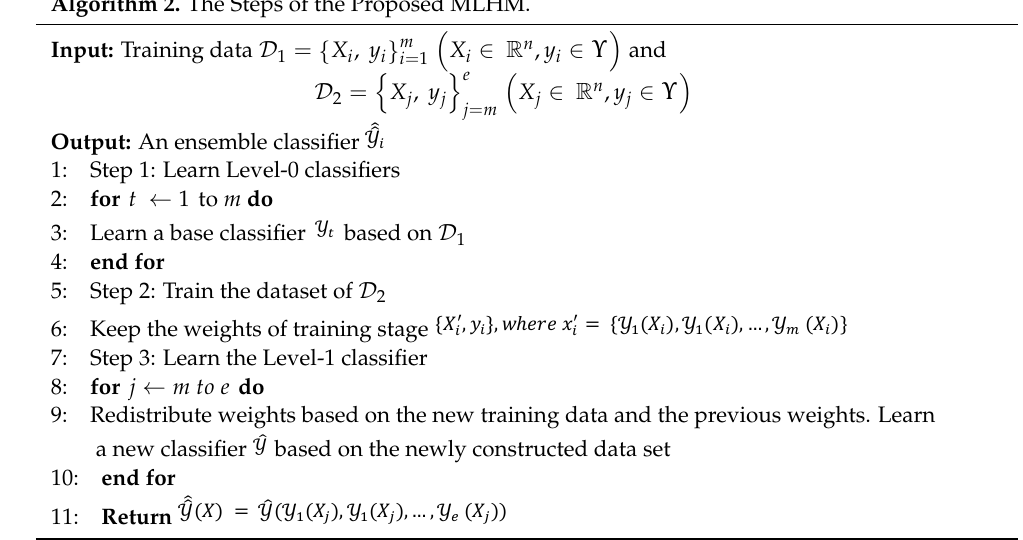
Algorithm 2. The Steps of the Proposed MLHM.